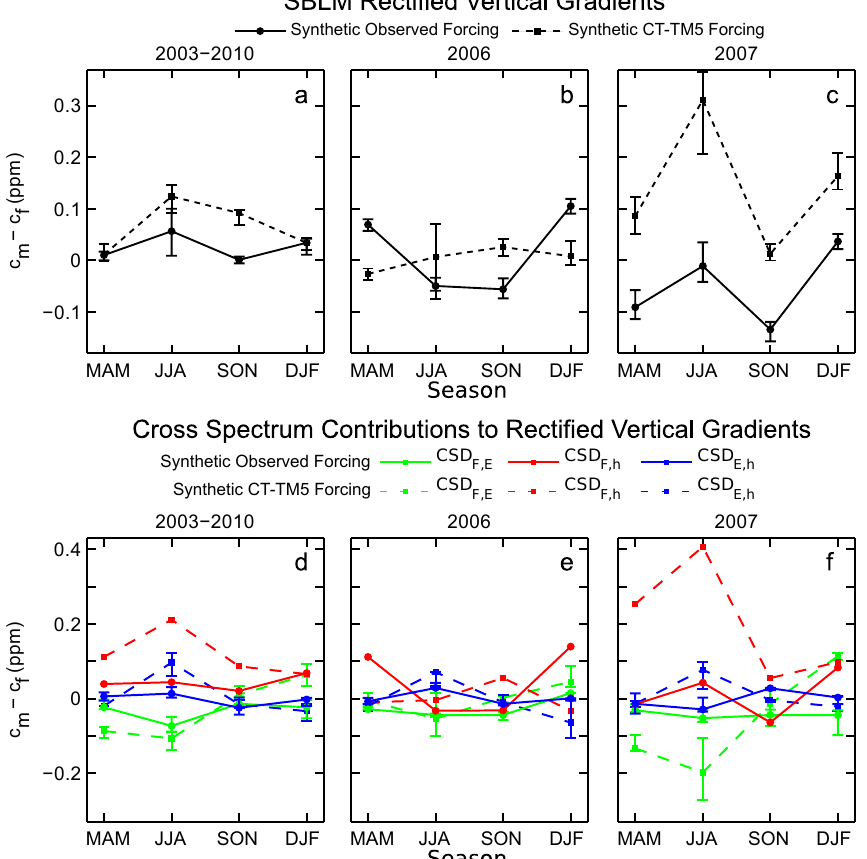
Fig. 5. Top row (a, b, c) : rectified vertical CO 2 gradients ( c m − c f ) predicted by SBLM forced with synthetic observations (solid), and synthetic CT-TM5 (dashed) with multivariate cross spectra fitted to the original time series, as shown in Figs. (1, 2). The stochastic model was fitted to cross spectra estimated over years 2002–2010 (a) , and for years 2006 (b) and 2007 (c) . The bottom row (d, e, f) shows separate contributions to the rectified gradients by each bivariate cross spectrum: CSD F,E (green), CSD F,h (red), and CSD E,H (blue). Rectified gradients are defined relative to a control vertical gradient given by the solution to SBLM forced with synthetic time series that all have zero cross spectra. Error bars show the range of solutions for 25% weaker and 25% stronger sub-grid-scale entrainment (see text for